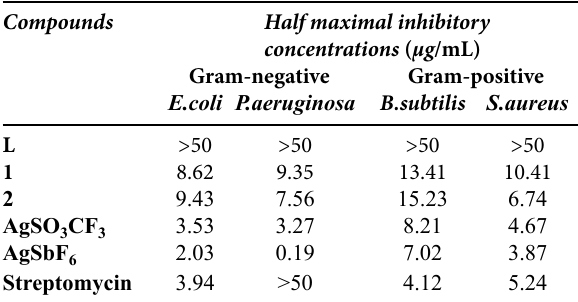
Table 4 Antimicrobial activity of the tested compounds. Compounds